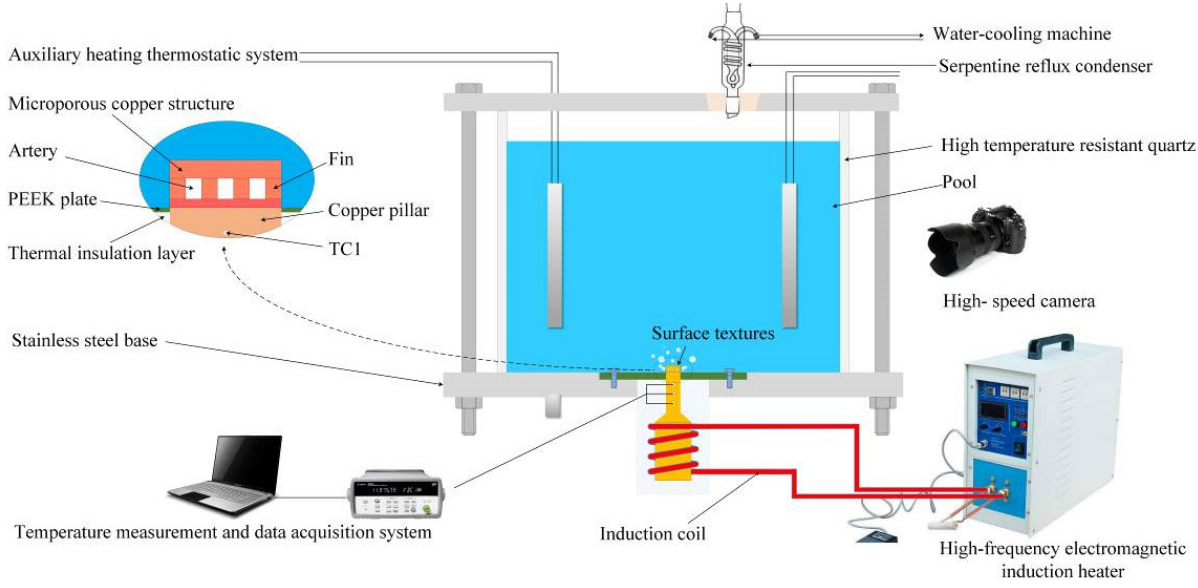
Figure 4. Schematic of the experimental setup.